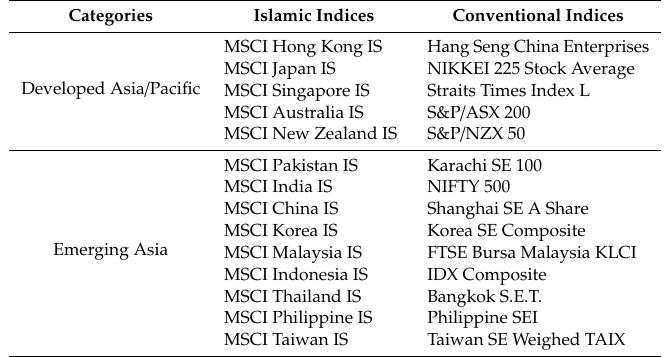
Table 1. The Asian Region’s Islamic and Conventional Stock